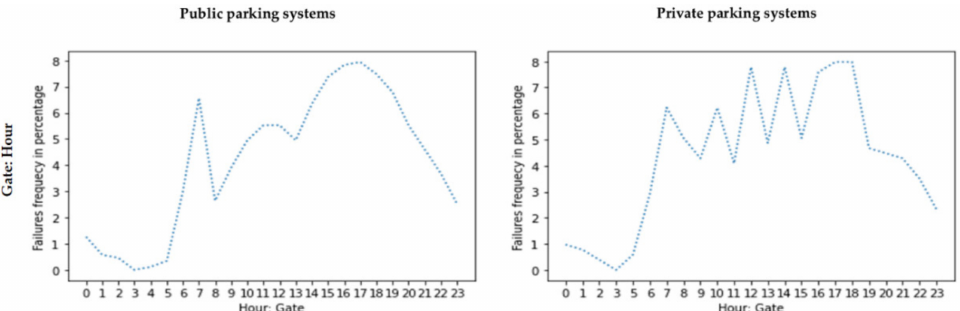
Figure 16. Time of day (hour) for all gate failure events in public ( left ) and private ( right ) parking